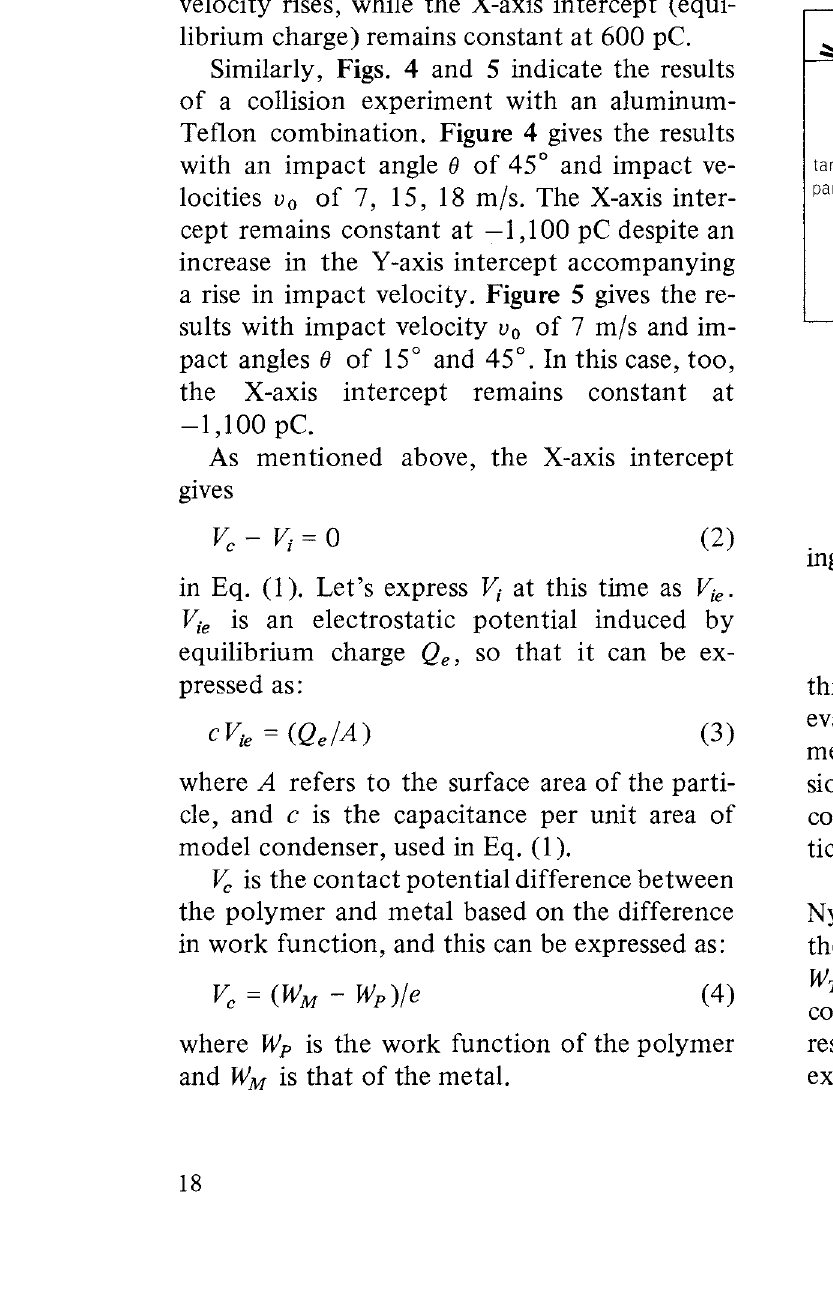
Fig. 4 Impact charge vs initial charge (Aluminum plate vs Teflon)